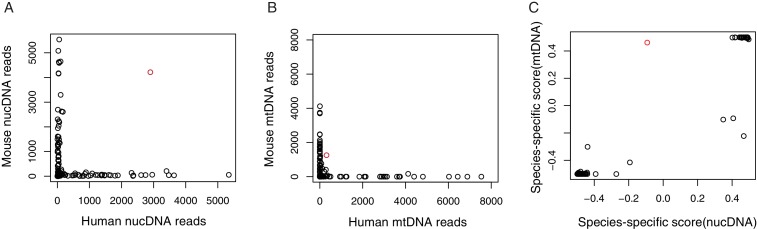
Investigation of horizontal mitochondrial transfer using mixing experiment from mouse and human cells.(A) Scatter plot shows the number of unique reads mapped to human and moue nuclear genome(nucDNA). Red circle indicates cell doublet. Sequence reads from each single cell were mapped to human and mouse combined reference genome. Unique mapped reads on nucDNA and mtDNA were counted respectively. (B) Scatter plot shows the number of unique reads mapped to human and moue mitochondrial genome(mtDNA). Red circle indicates cell doublet. (C) Species-specific score for nucDNA and mtDNA. The species-specific score was calculated with (Chuman/(Chuman + Cmouse)−0.5. ‘−0.5’ or ‘0.5’ indicate 100% alignment to mouse or human reference. The positive correlation between nucDNA and mtDNA indicates the species-specific mtDNA always paired with species-specific nucDNA.